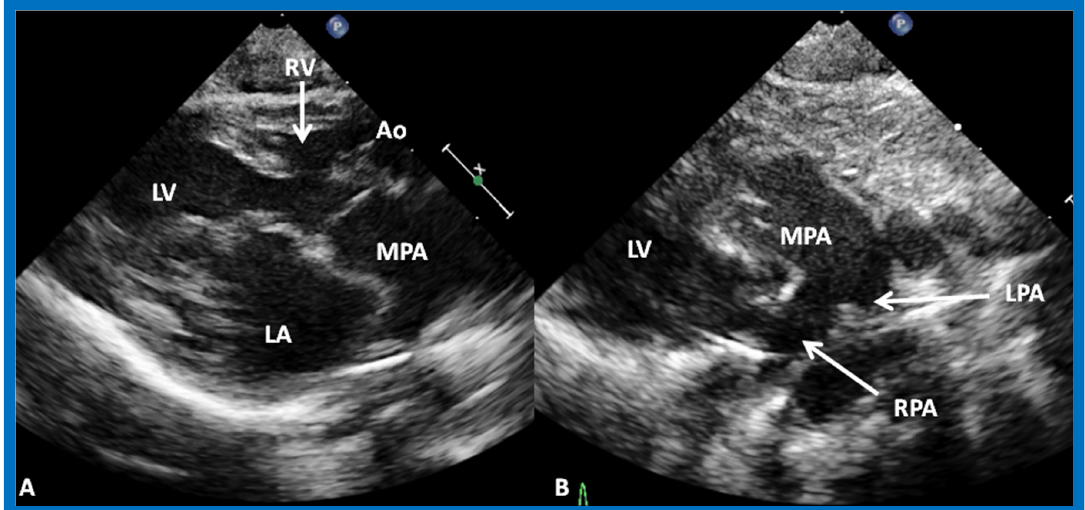
artery. Reproduced from Rao P.S. [39].